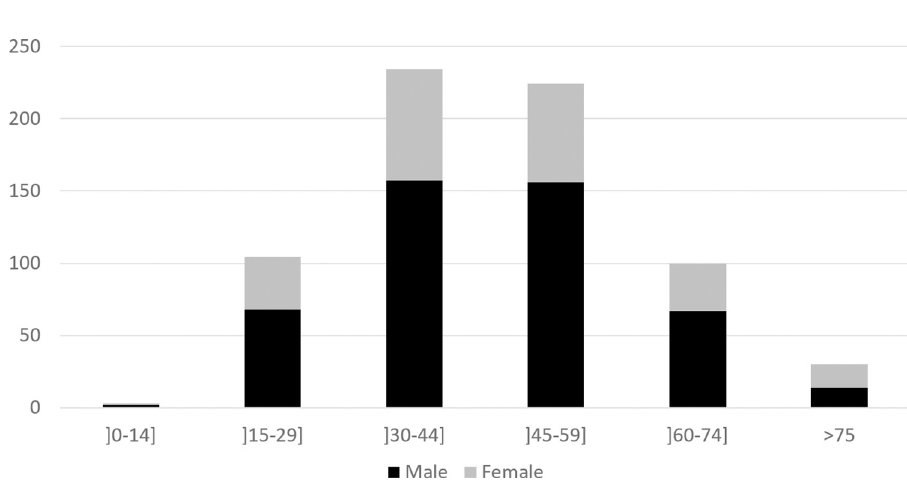
Fig 2. Number of cases according to the age category. F = female, M = male.